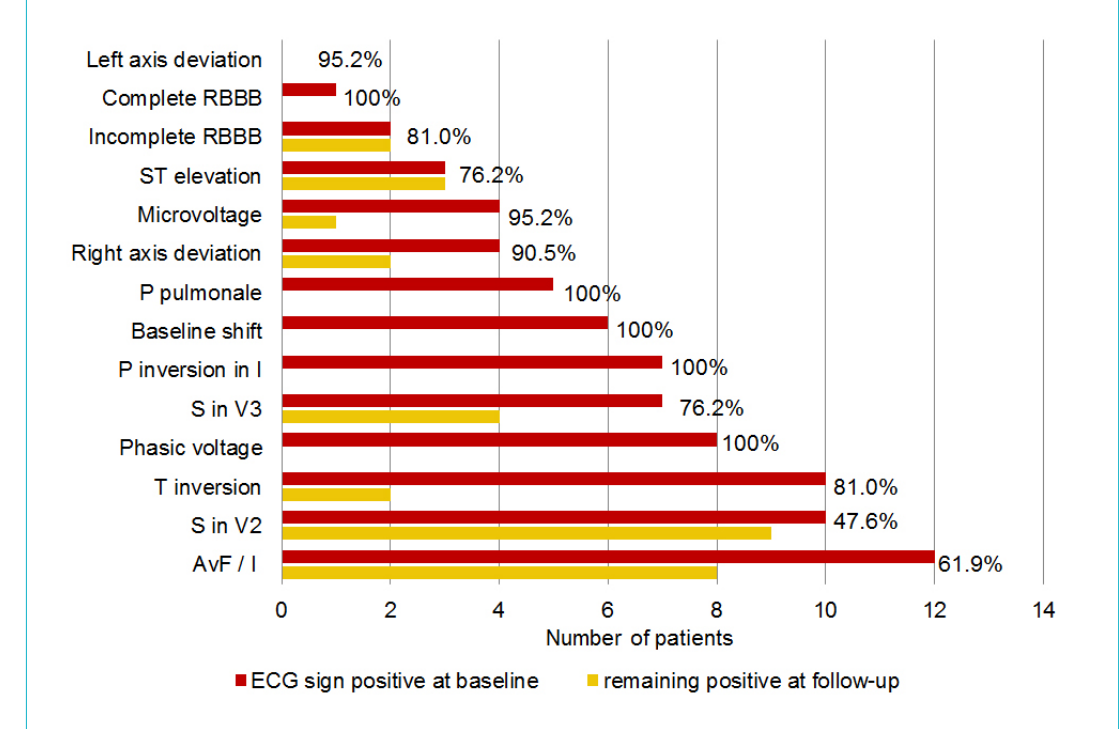
Figure 3: Prevalence (number of patients) and evolution of positive ECG signs in 21 patients with pneumothorax and a follow-up ECG. The number at the end of the bars denotes the specificity for the ECG sign in this subgroup of 21